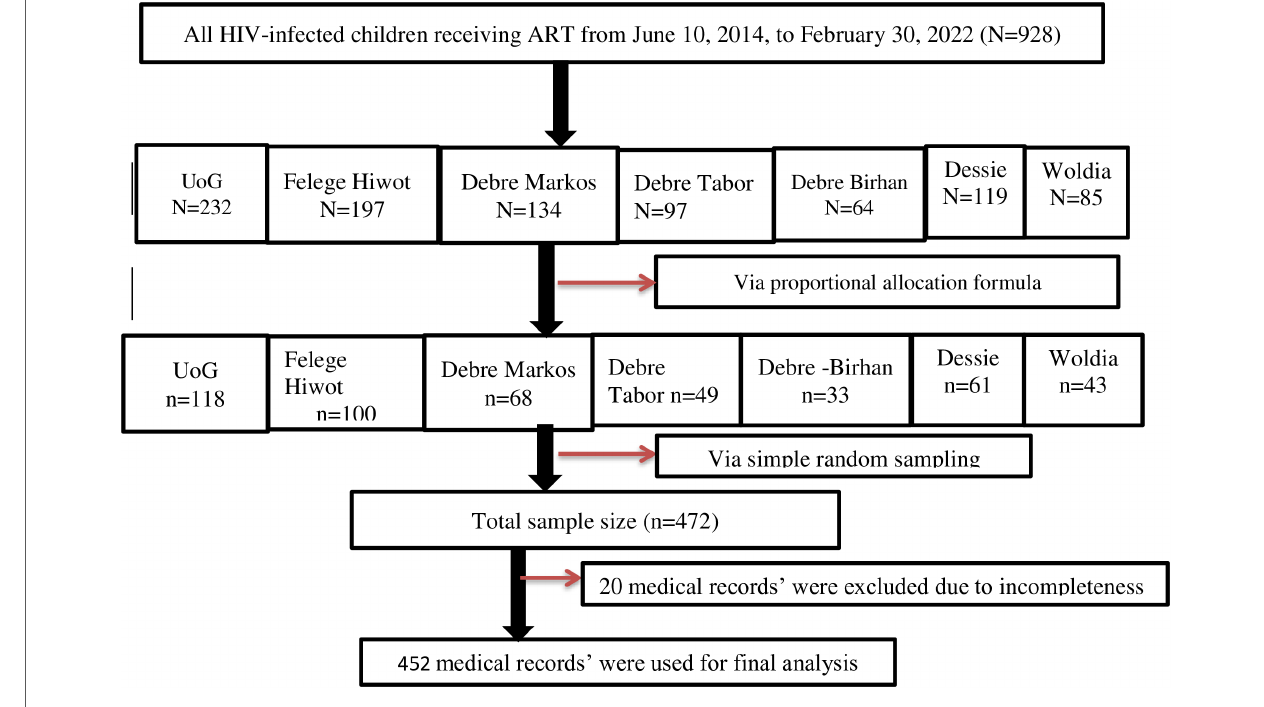
FIGURE 1 Schematic diagram of the sampling procedure for assessment of the incidence and predictors of OIs among HIV-infected children receiving ART at Amhara regional state comprehensive specialized hospitals in Ethiopia in